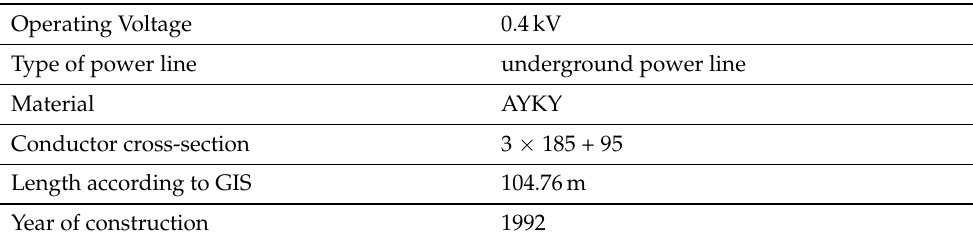
Table 2. Basic description and parameters of power line.